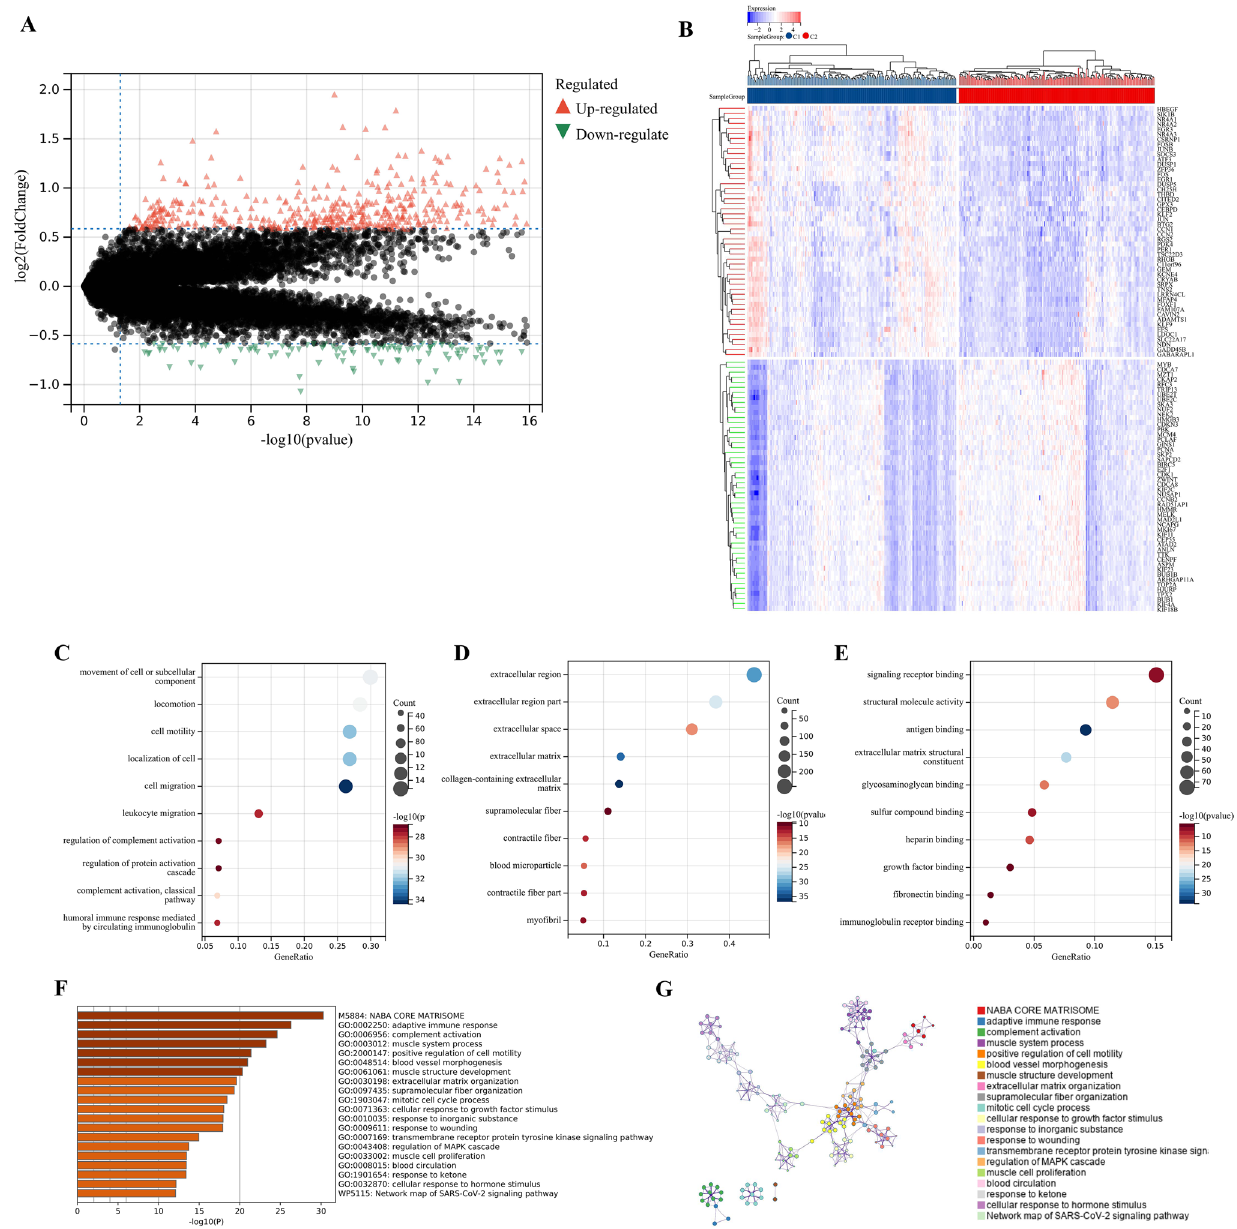
Figure 9. Identification of DEGs and Functional Enrichment Analysis. ( A ) Volcanic map of DEGs in training cohort. ( B ) Heatmap of DEGs in training cohort. ( C – F ) BP, CC, MF, and the whole gene ontology (GO) Analysis of DEGs in training cohort. ( G ) PPI analysis of GO Analysis in training cohort. ( H ) Circle diagram of KEGG in training cohort. ( I ) PPI analysis of KEGG enrichment analysis. ( J ) Heatmap of GSEA analysis